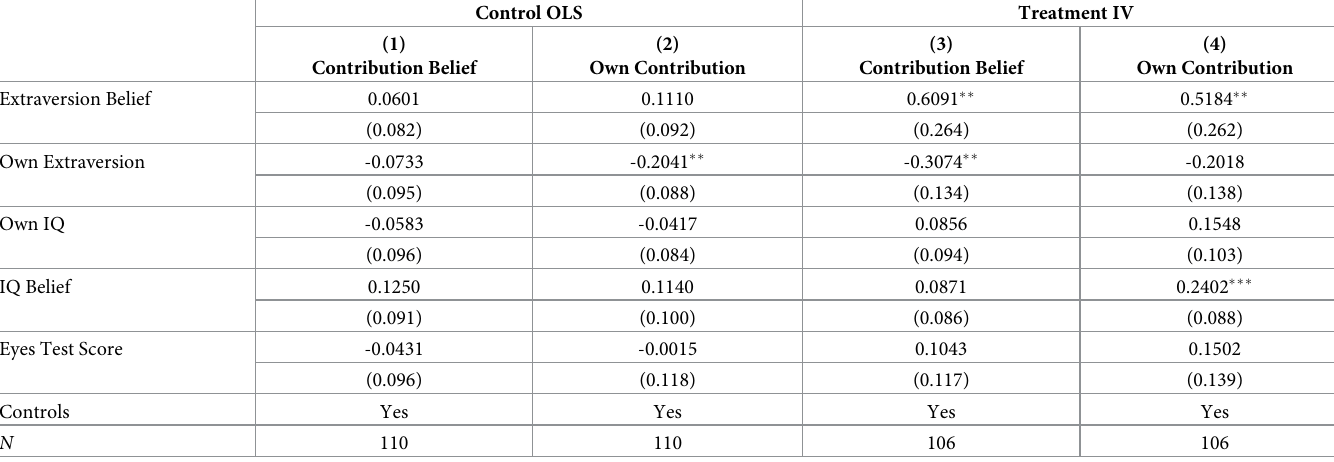
Table 7. Impact of beliefs about partner’s personality and own personality on beliefs about partner’s contribution and own contribution in public goods